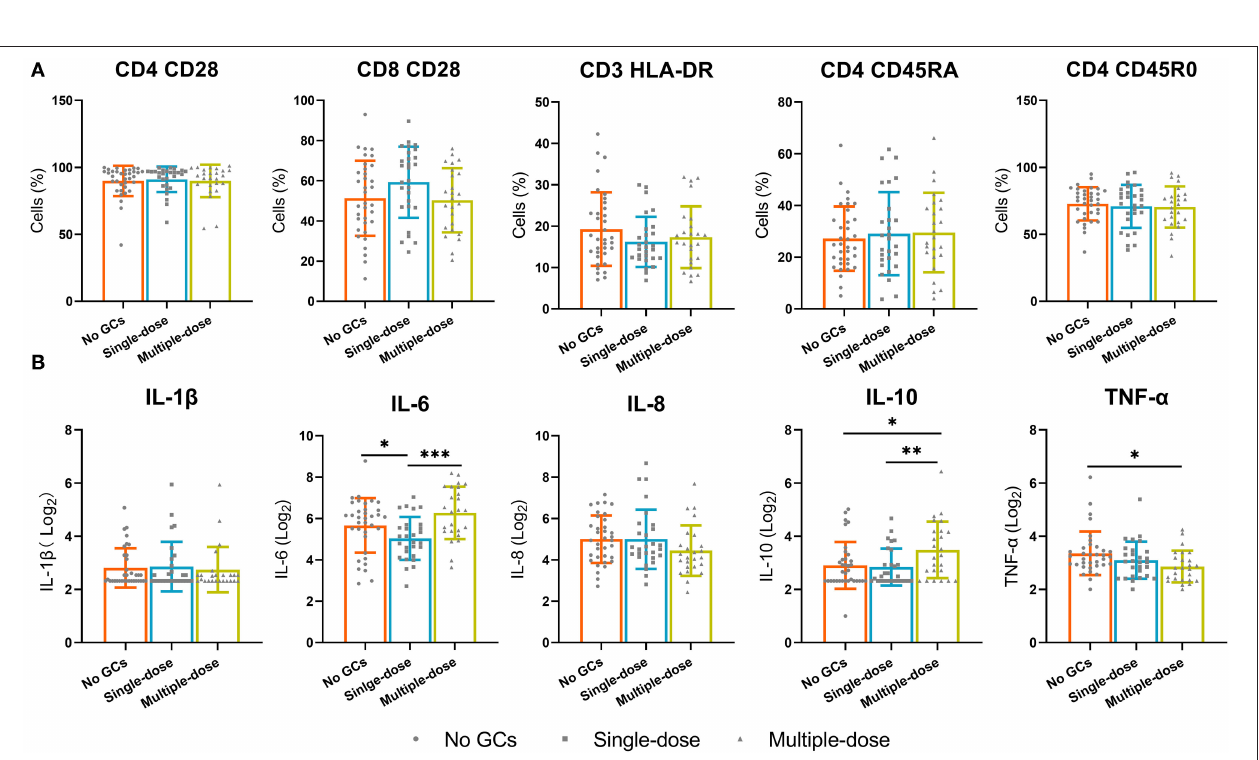
FIGURE 4 | The lymphocyte phenotypes and known inflammatory cytokines in the no GCs group, single-dose group, and multiple-dose group. (A) The expression of CD28 on CD4 + and CD8 + T cells, the expression of HLA-DR on CD3 + T cells, the expression of CD45R0 and CD45RA on CD4 + T cells. (B) Inflammatory factors. * p < 0.05, ** p < 0.01, *** p < 0.001.